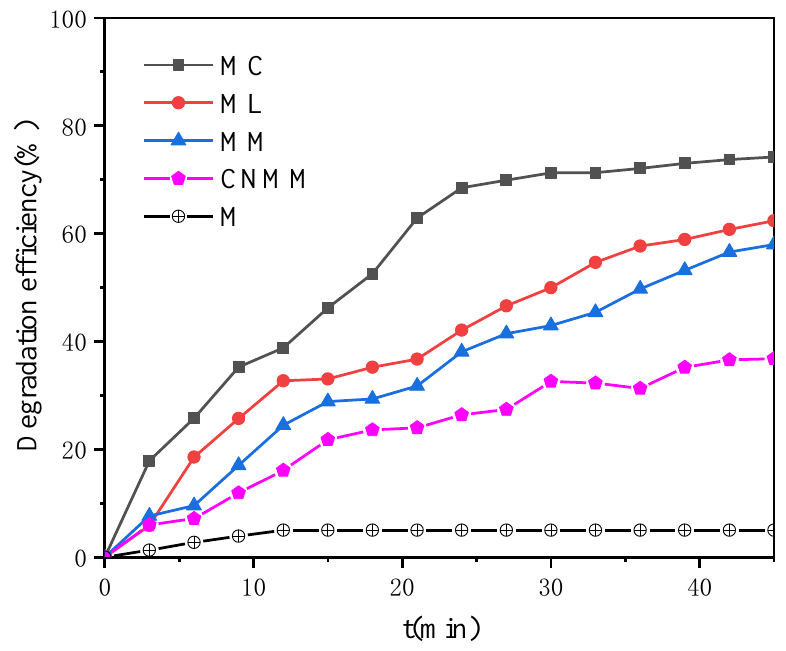
Figure 10. Photocatalytic NO x degradation efficiency of different cement mortars.